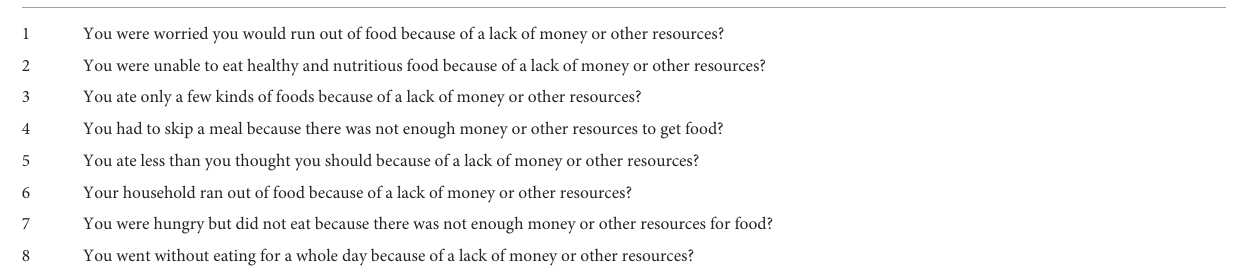
TABLE 1 Food insecurity experience scale